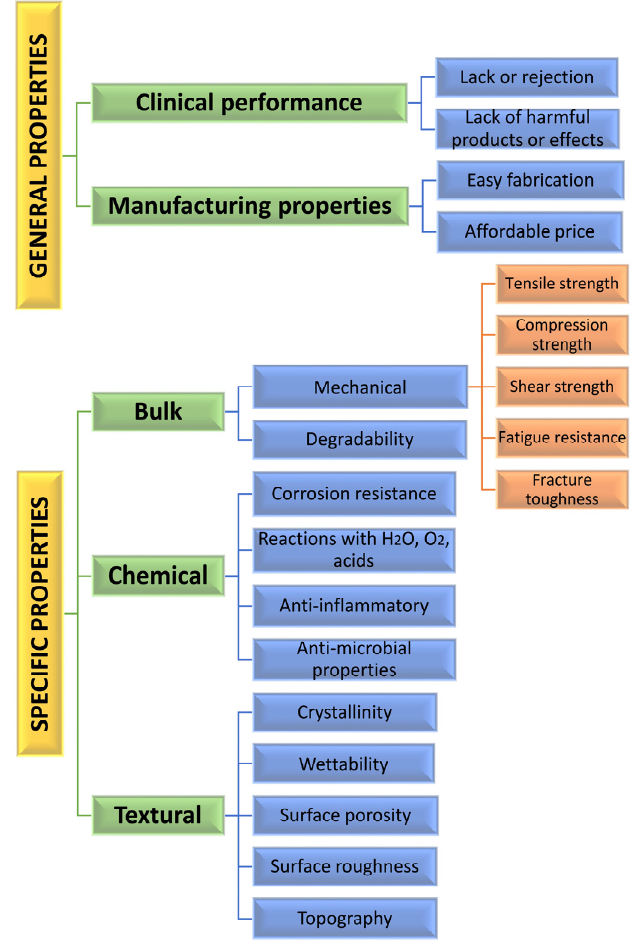
Figure 2. Classification of vital properties of biomaterials .